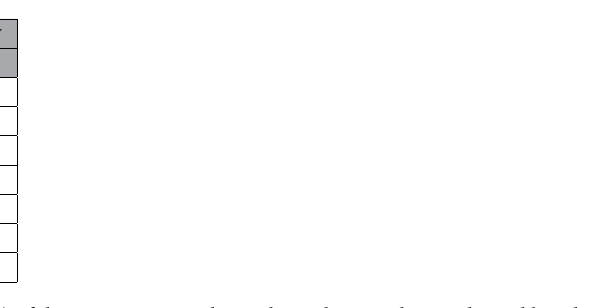
Table 3. Chemical composition (in at.%) of the precipitates in the peak-aged AX10 sheet indicated by white arrows in Fig. 5a, analyzed by STEM-EDS.